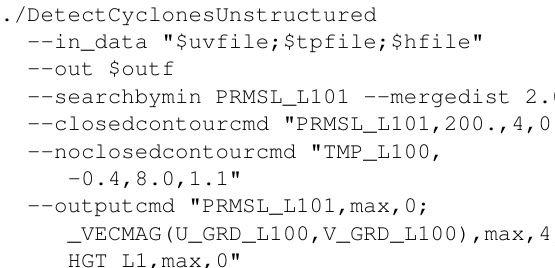
Figure 5. Tropical cyclone counts within each 2 ◦ over the period 1979–2010, obtained using the procedure described in Sect.